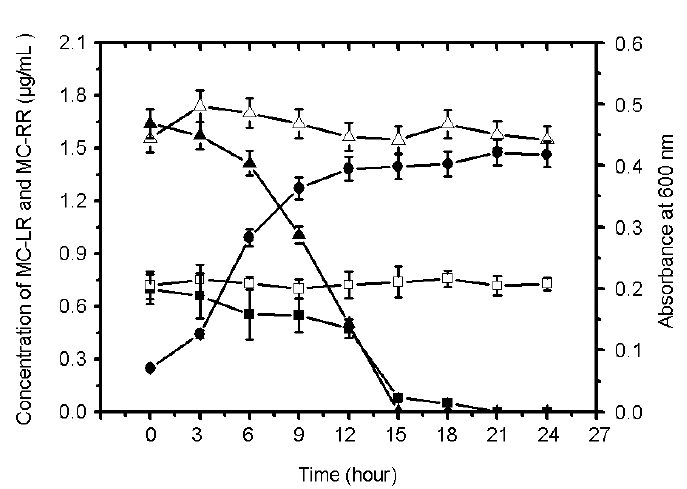
Figure 6. Degradation of MC-LR and MC-RR by strain EMS. Strain EMS growth in M9 medium containing crude MCs extract was detected by measuring the absorbance of the culture at 600 nm ( ● ). Concentrations of MC-LR ( ■ ) and MC-RR ( ▲ ) were measured every 3 hours. ((cid:31)) and ( □ ) indicate the concentrations of MC-LR and MC-RR in medium without bacteria, respectively. Vertical bars represent standard deviation of the mean (n =